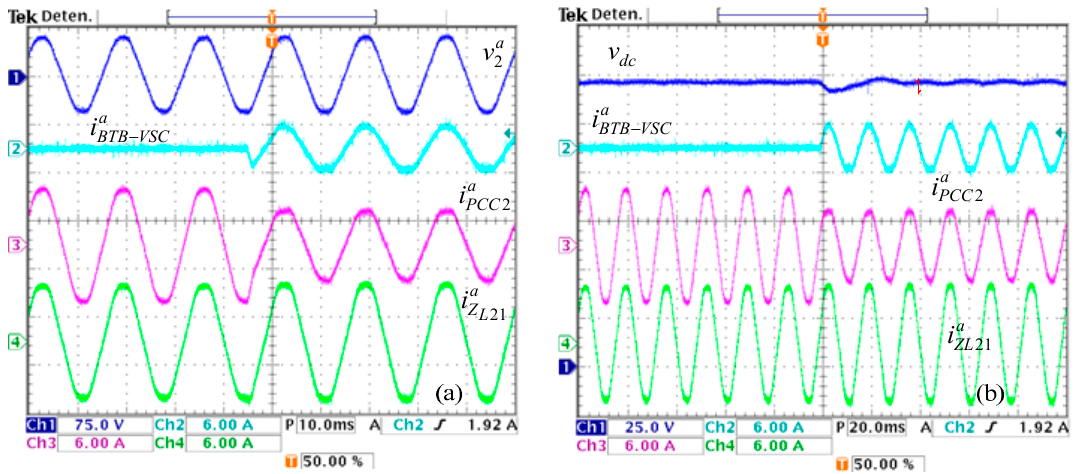
Figure 13. Test results for active power regulation: ( a ) Ch1, voltage measured at the PCC2; Ch2, current injected with the BTB-VSC at the PCC2; Ch3, current measured at the PCC2; Ch4, current for the load Z L 21 . Vertical sensitivities: Ch1, 75V/div; Ch2-Ch4, 6A/div. Horizontal sensitivity: 10 ms/div. ( b ) Ch1, DC bus voltage; Ch2, current injected with the BTB-VSC at the PCC2; Ch3, current measured at the PCC2; Ch4, current for the load Z L 21 . Vertical sensitivities: Ch1, 25V/div; Ch2-Ch4, 6A/div. Horizontal sensitivity: 20 ms/div.